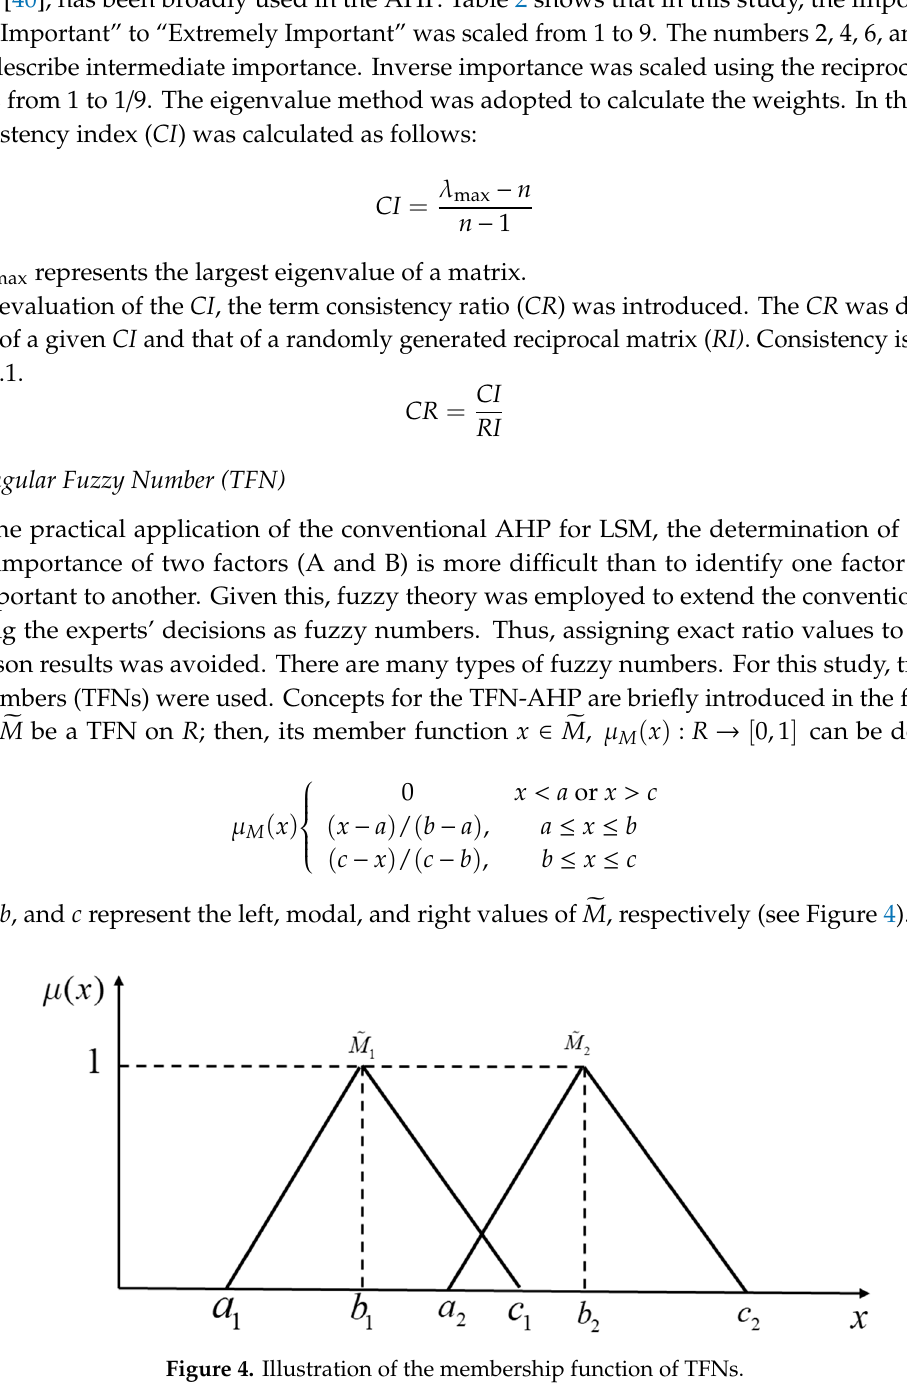
Table 2. Triangular fuzzy scale used in this study.